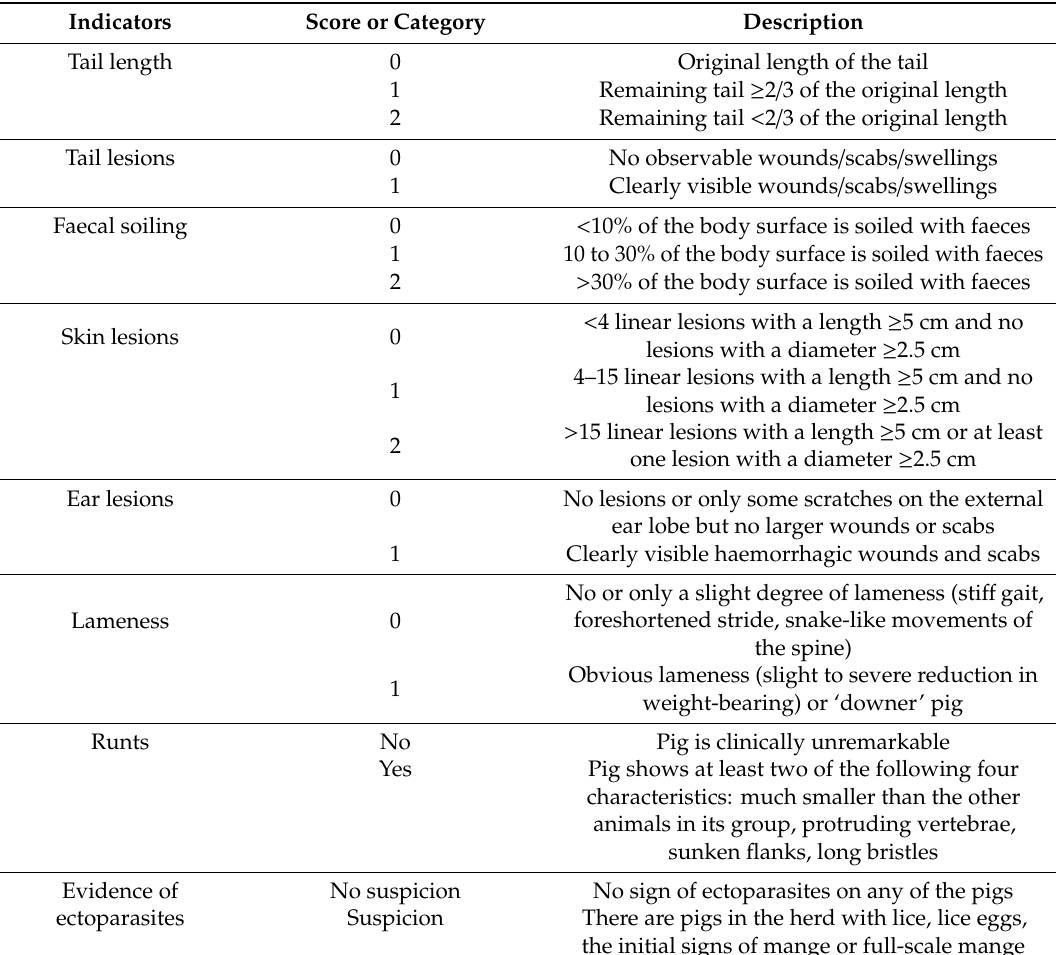
Table 2. Description of the scores or categories of the KTBL indicators which should be recorded for individual fattening pigs (according to